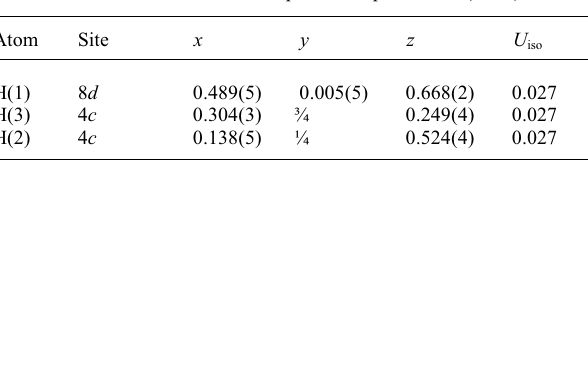
Table 2. Atomic coordinates and displacement parameters (in Å 2 ) .